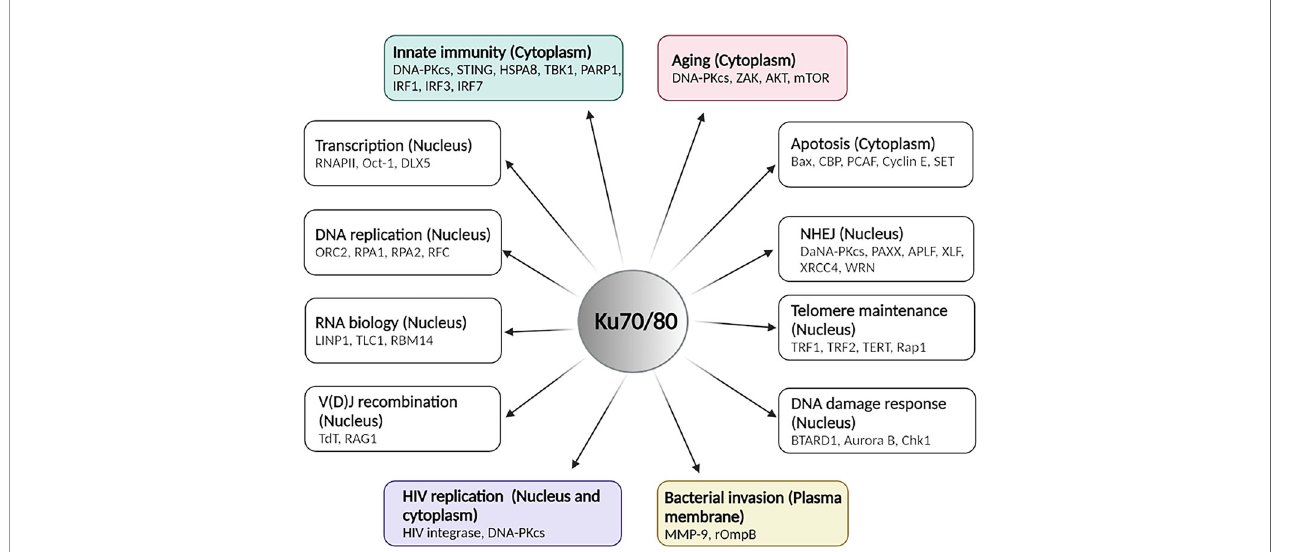
FIGURE 2 | The overview of functions of Ku70/80 heterodimer in various cellular contexts. Ku70/80 ’ s involvement in multiple cellular activities with indicated cellular localization and critical mediators. This illustration was created by using BioRender. The fi gure was adapted from the 2021 review by Abbasi et al. (Abbasi et al.,